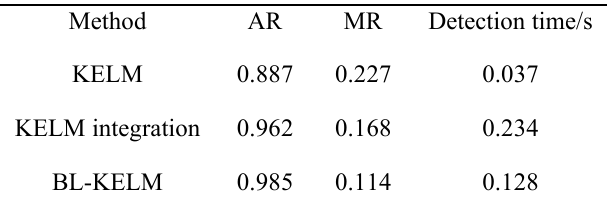
Table 3. The effect of U on performance of